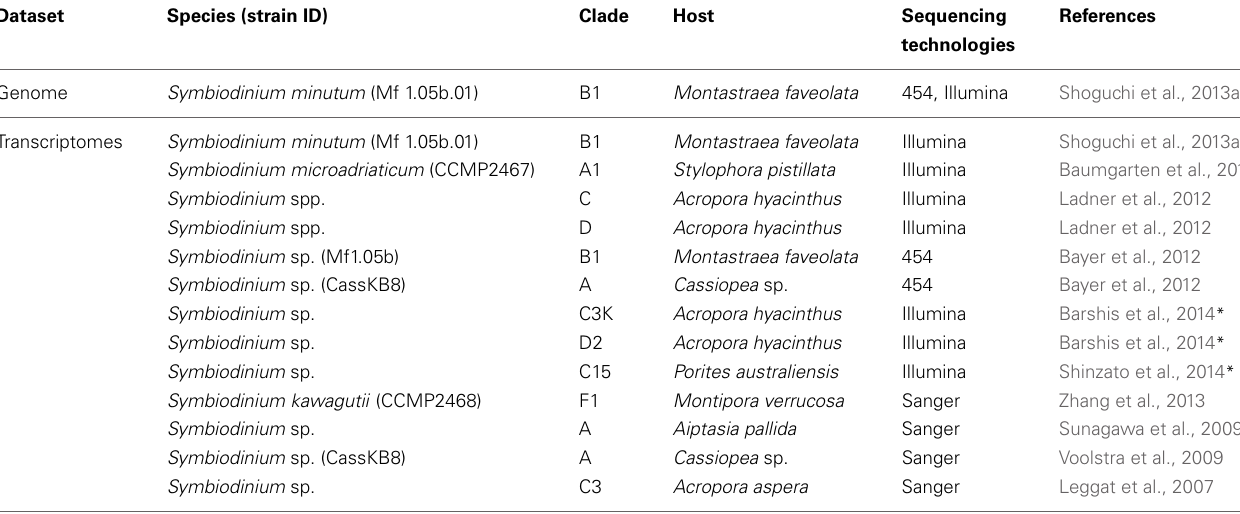
Table 2 | Published genomics and transcriptomics datasets of Symbiodinium.